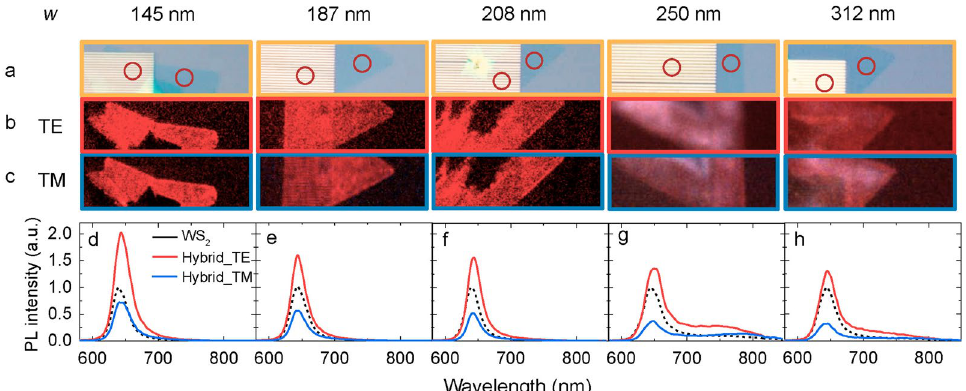
Figure 4. Anisotropic enhancement of the direct bandgap emission as a function of the wire width. ( a ) Optical images of the WS 2 -Ag wire hybrid nanostructures. From left to right, the width of the nanowire is 145, 187, 208, 250 and 312 nm, respectively. ( b )–( c ) Corresponding PL images for TE and TM polarizations. ( d )–( h ) Corresponding PL spectra for the pristine WS 2 (black dashed curves), WS 2 -Ag wire hybrid nanostructures in TE (red solid curves) and TM (blue solid curves) polarization